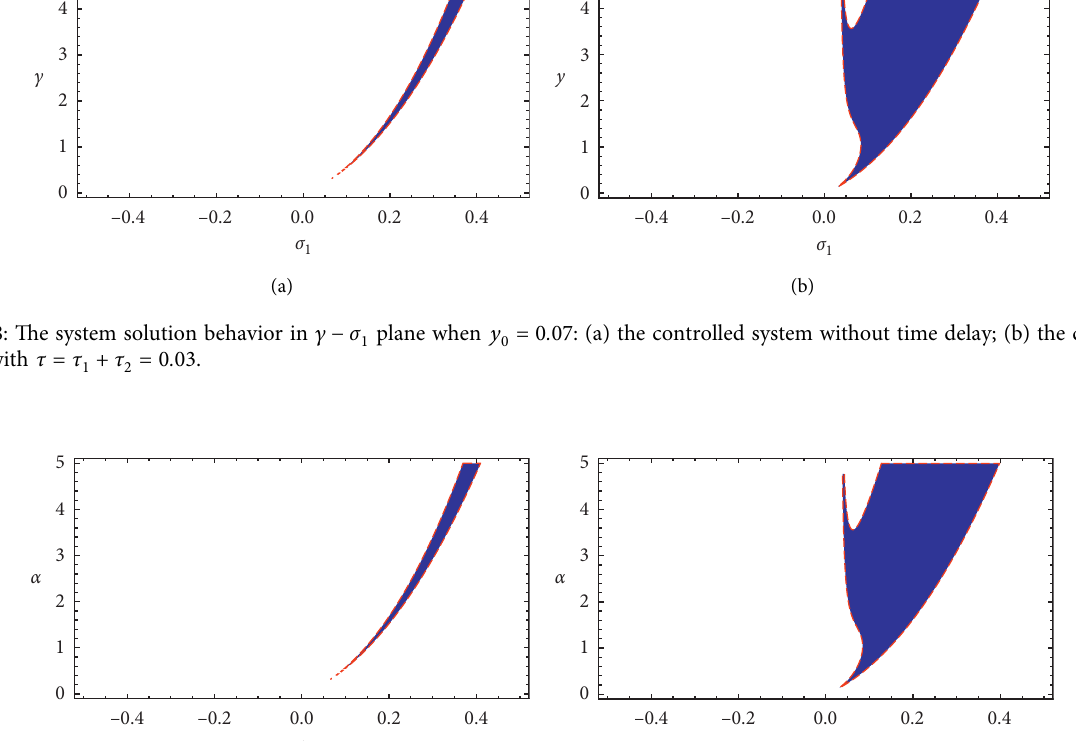
� 0 . 07: (a) the controlled system without time delay; (b) the controlled plane when y 1 0